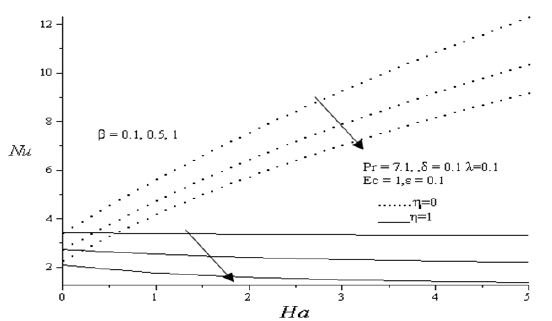
Figure 10. Nusselt number with increasing Ha and β .